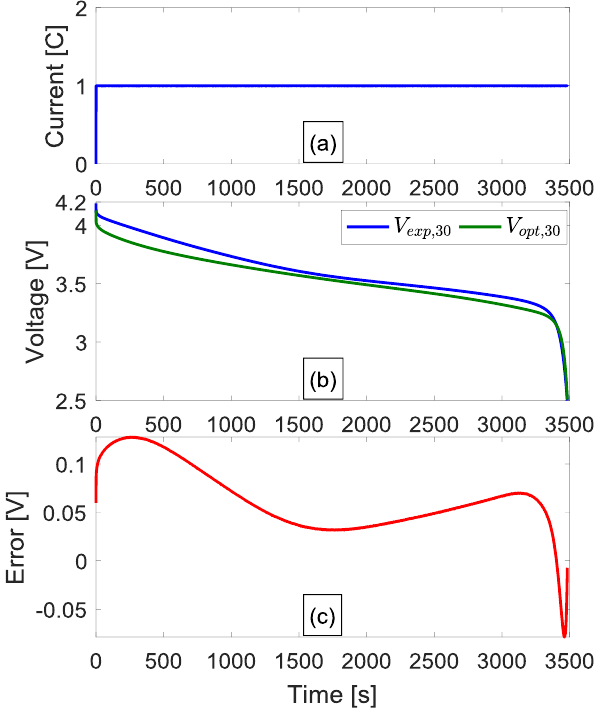
Figure 9. Validation results under 1C-rate discharge condition at 23 °C: ( a ) input current profile; ( b ) voltage; and ( c ) voltage error.